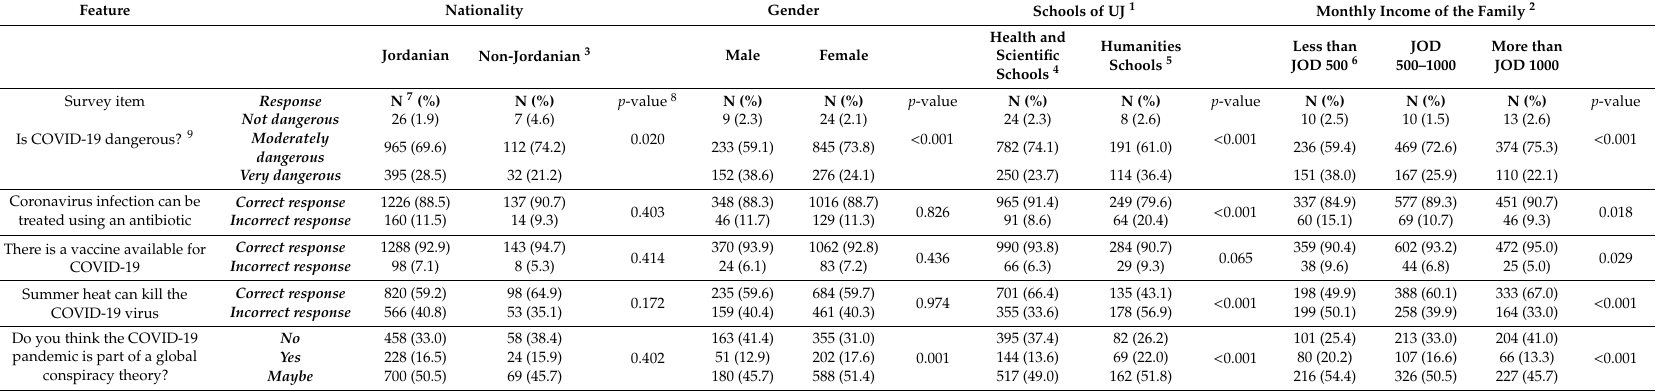
Table 2. Response of study participants regarding danger of COVID-19, knowledge and belief in